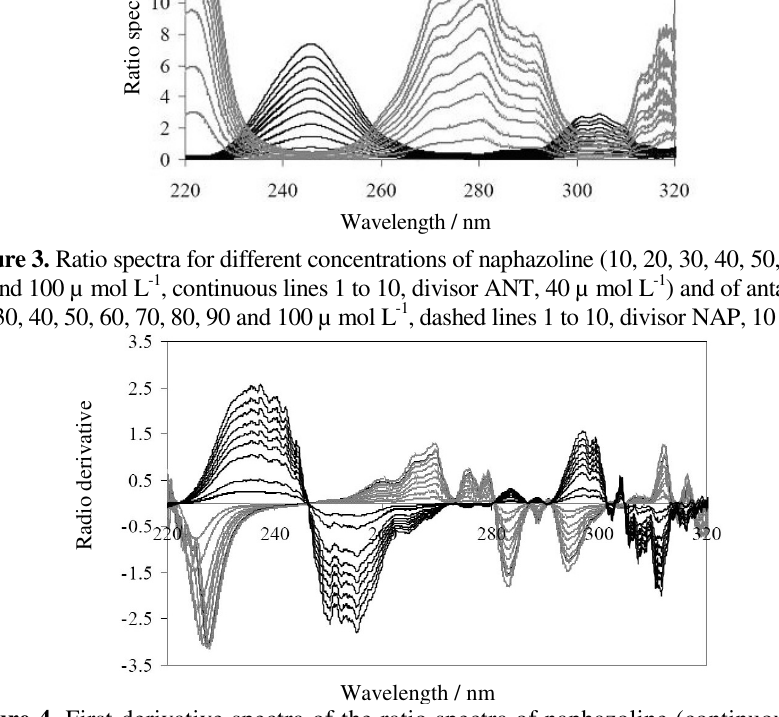
Figure 4. First-derivative spectra of the ratio spectra of naphazoline (continuous lines) in 40 µ mol L -1 ANT as divisor and antazoline (dashed lines) shown in 10 µ mol L -1 NAP as